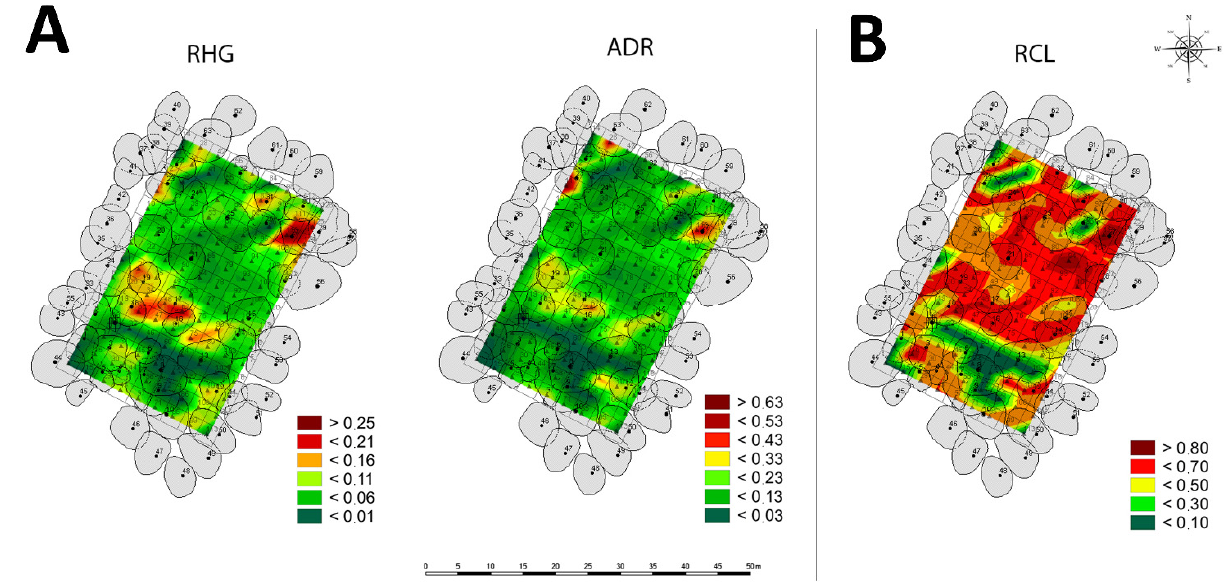
Figure 2. Example of visualized similarities between relative height growth (RHG) and apical dominance ratio (ADR) ( A ) and example of relative crown length (RCL) ( B ) of Norway spruce juveniles under a mature overstory canopy on the largest research plot Drti č ( A ). For all three indexes, a deep green color indicates highly suppressed growth regimes characterized by (i) short terminal length (as numerator in RHG and ADR); (ii) lateral crown growth encouraged by long branch length (as denominator in ADR); (iii) shortened crown length (as numerator in RCL).